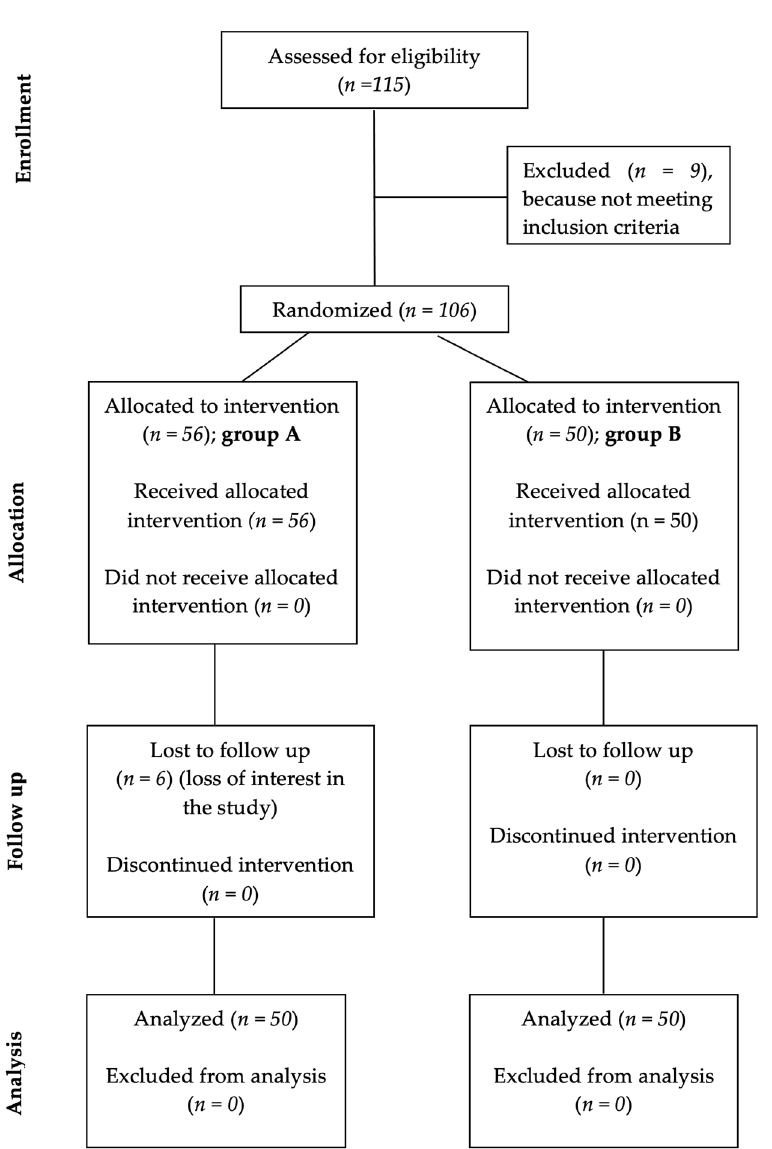
Figure 1. CONSORT type flow chart presenting patients’ selection and their therapeutic manage- ment.